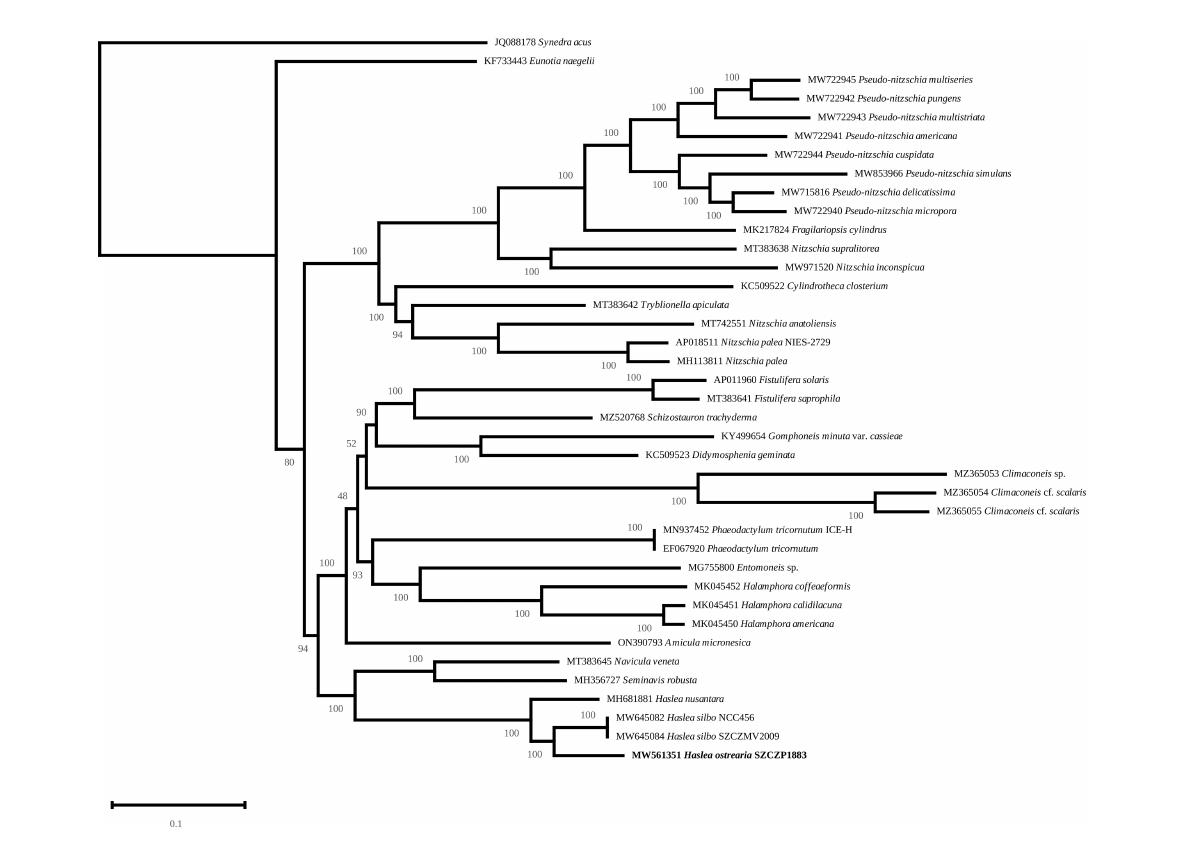
FIGURE 10 Maximum Likelihood phylogenetic tree inferred from an alignment of all protein coding genes from the plastome of 39 taxa of diatoms and rooted with Synedra acus (Log-likelihood: -1139126.5259). The scale indicates the number of substitutions per site.